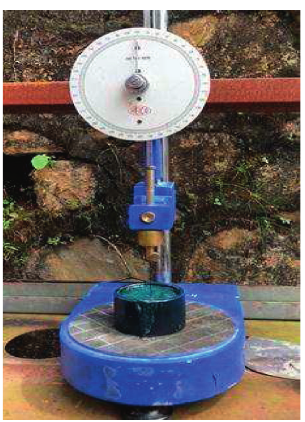
Figure 2: Penetration test.